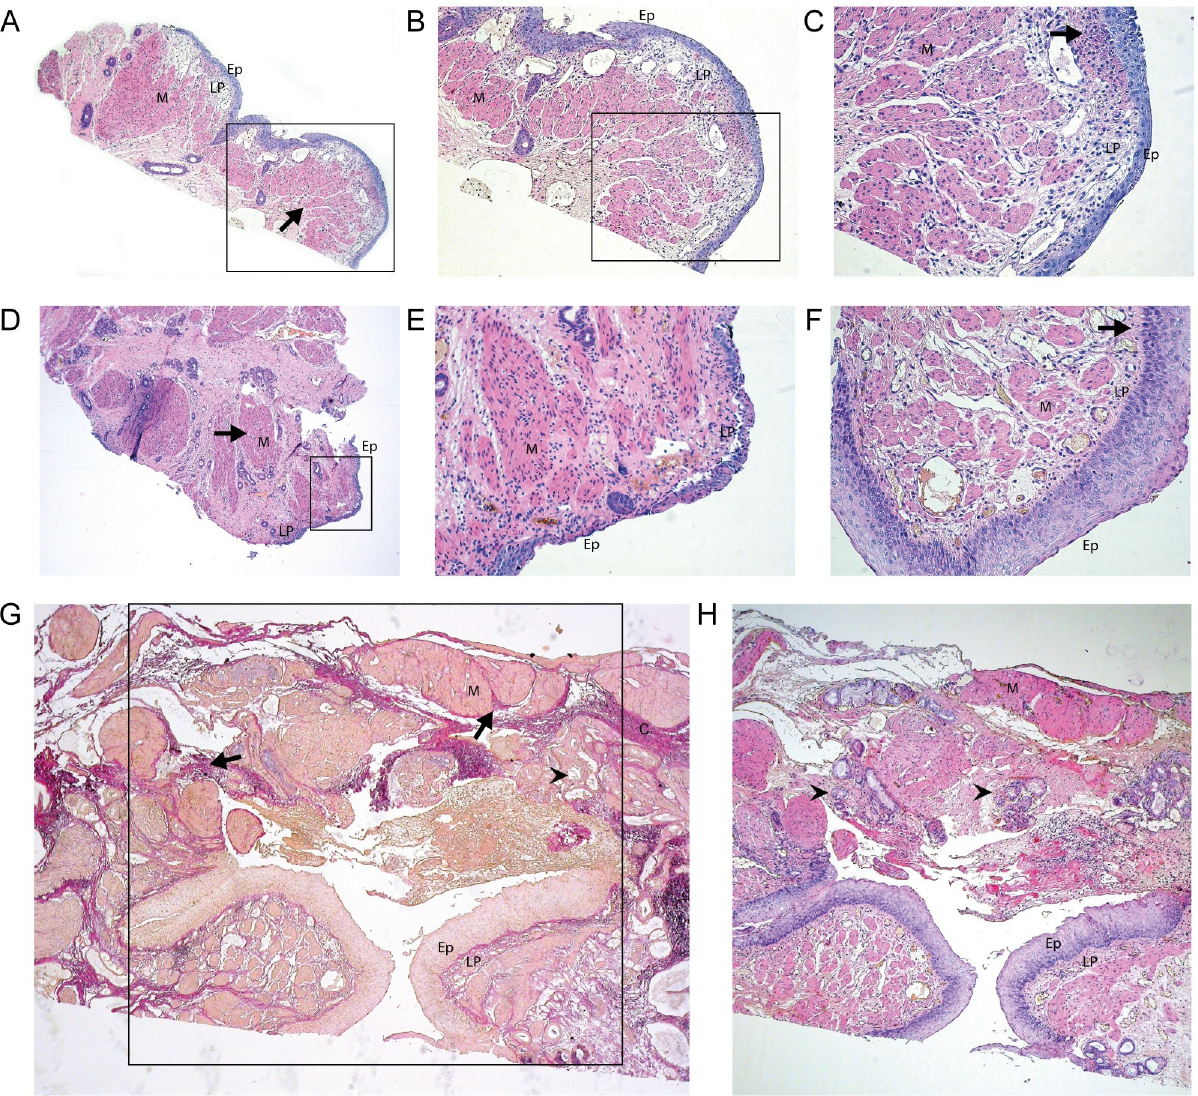
Fig 2. A-D. Overview and details of TEF. TEF walls covered by squamous epithelium (ep), with underlying lamina propria (lp) and muscular layer (m). The muscle layer appears irregular and fragmented in the overview of A-C and D, E and F. In the detail images a mild chronic inflammatory infiltrate can be appreciated. (at 4x, 10x and 40x magnification respectivly) G. Elastic and corresponding HE stain (H) of fistula covered with squamous epithelium, showing disorganized muscle bundles and glandular structures. (at 10x